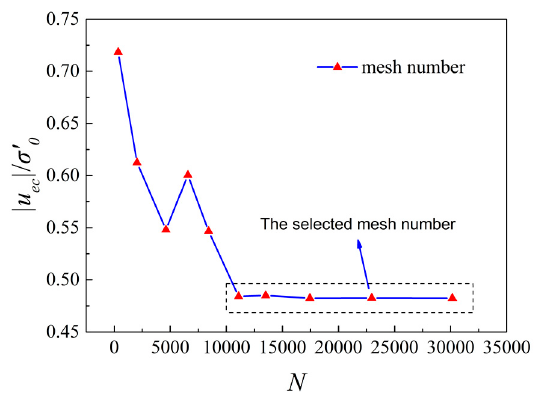
Figure 2. Variation of the wave induced maximum excess pore pressure ( |u ec | / σ ’ 0 ) (at point A in Figure 1) with the mesh number N .